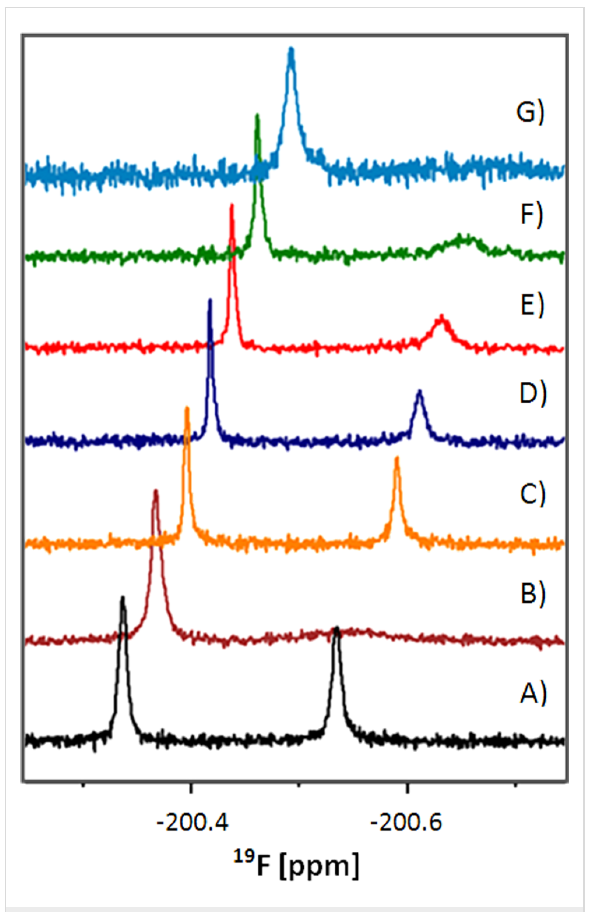
Figure 5: Competitive titration with the 2-F-maltose reporter system and 19 F NMR: only the important section of the gluco-type isomers is shown. (A) 2-F-maltose, (B) 2-F-maltose bound to MBP, (C–G) addi- tion of 0.125 equiv of the following maltose derivatives: (C) 6-F- maltose, (D) maltose, (E) α –maltosyl fluoride, (F) 6 ′ -F-maltose, (G) 6 ′ -F-“galacto”-maltose. Spectra were recorded on a Bruker Avance DRX 600 MHz spectrometer by using a conventional 1-D pulse sequence. Up to 128 scans were acquired without signal suppression via T2 relaxation